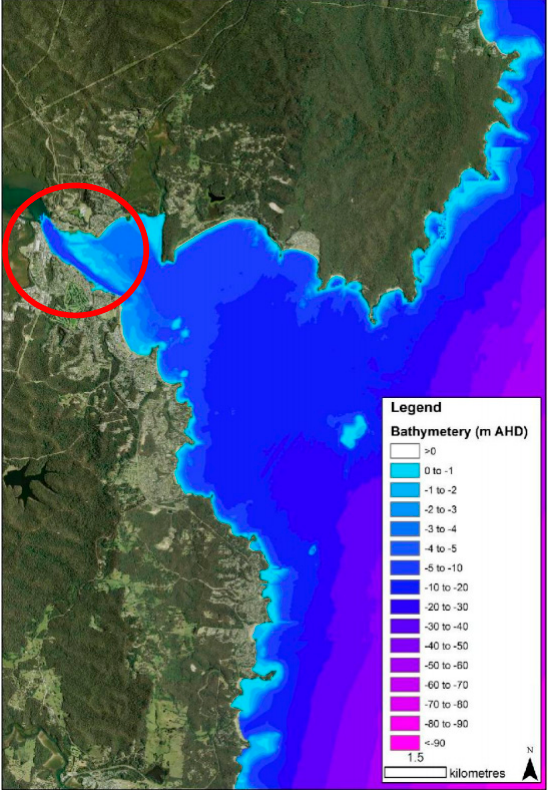
Figure 10. 2017 bathymetry data for Batemans Bay, with the deepened channel circled in red (Water Research Laboratory, 2017).